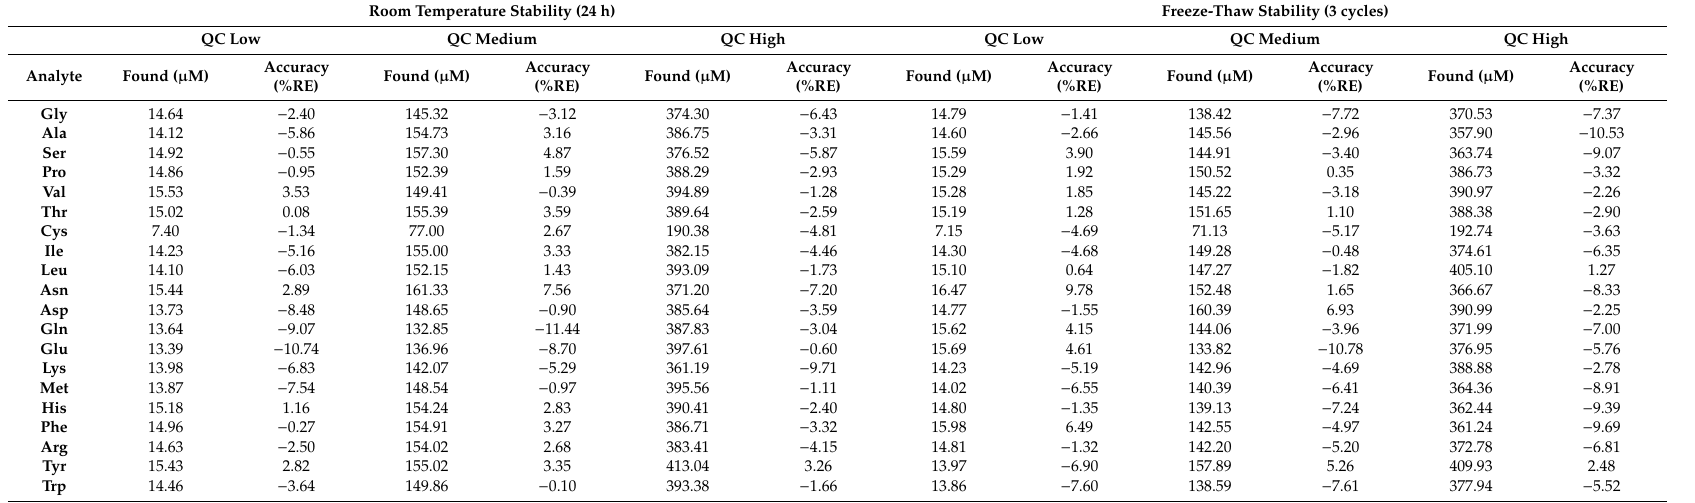
Table 4. Stability testing of 20 amino acids in QC